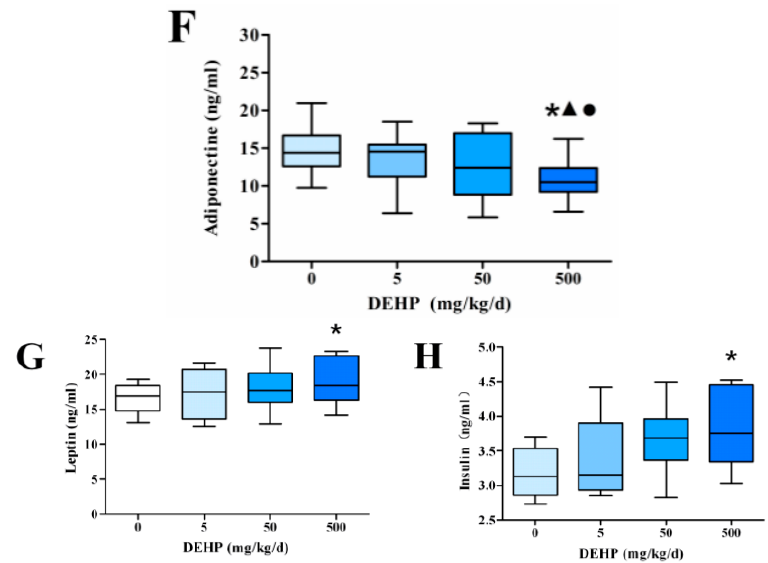
Figure 1. Effects of 4 weeks of dietary exposure to DEHP on body weight, serum lipid levels and related hormone levels in rats ( n = 20 animals/ each group). ( A ) The body weights; ( B ) Total cholesterol (CHO) level; ( C ) Triglyceride (TG) level; ( D ) High density lipoprotein (HDL) level; ( E ) Low density lipoprotein (LDL) level; ( F ) Adiponectin level; ( G ) Leptin level; ( H ) Insulin level. The body weight was expressed as the mean value ± standard error (SE), serum lipid levels and related hormone levels were expressed as the min to max and the median. • Statistically significant difference compared with 50 mg·kg − 1 ·d − 1 ( p < 0.05); ▲ Statistically significant difference compared with 5 mg·kg − 1 ·d − 1 ( p < 0.05); * Statistically significant difference compared with control ( p < 0.05).